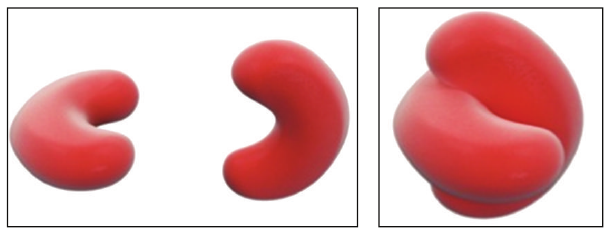
Figure 9: Supposed spatial arrangement of qRBCs in a three- dimensional (3D) draw.